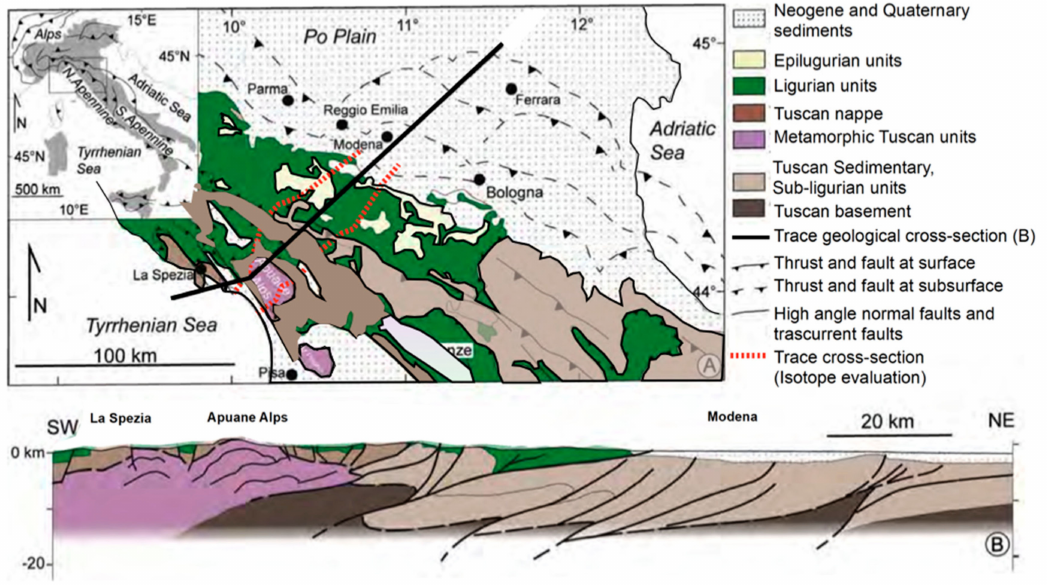
Figure 1. ( A ) Study area. ( B ) Simplified geological scheme and section (trace is represented by the black line), from [34],